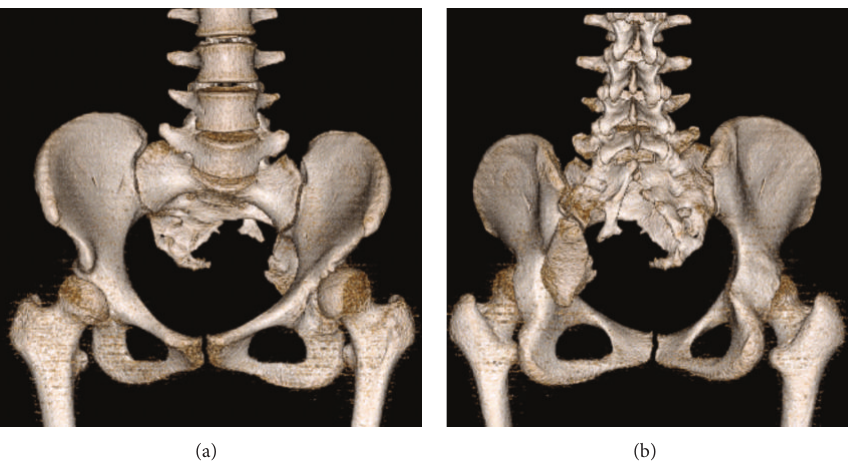
Figure 2: Pelvic three-dimensional CT reconstruction images demonstrated partial left sacral agenesis, in which a rudimentary sacrum had fused with the ilia below the sacroiliac joint. (a) AP view. (b) PA view.